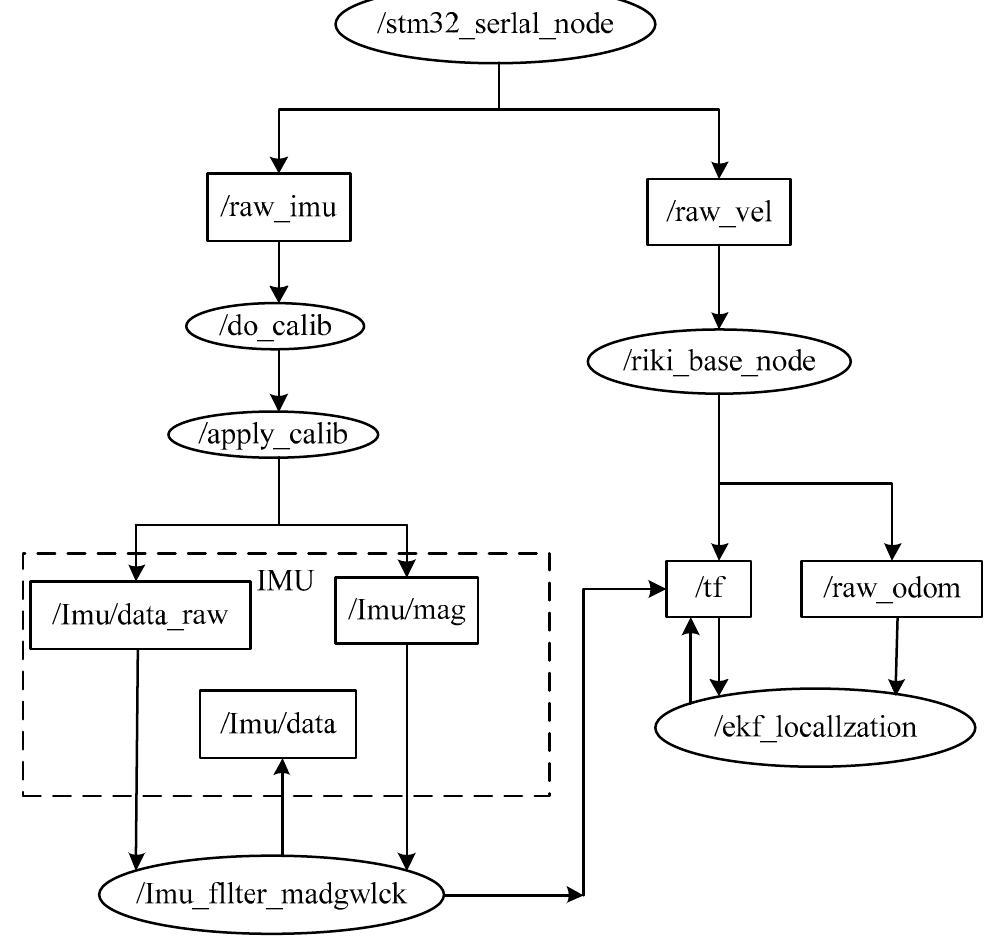
Figure 9. The flowchart of nodes in the software.